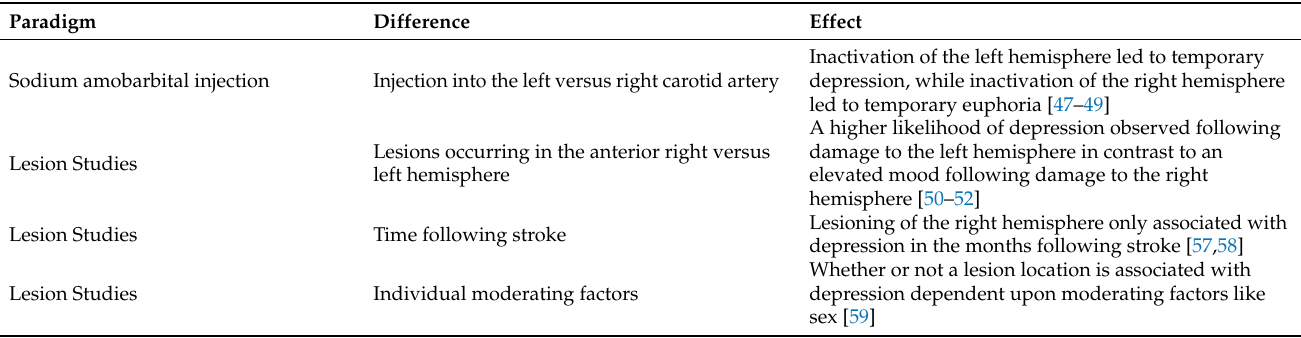
Table 1. Brief summary of